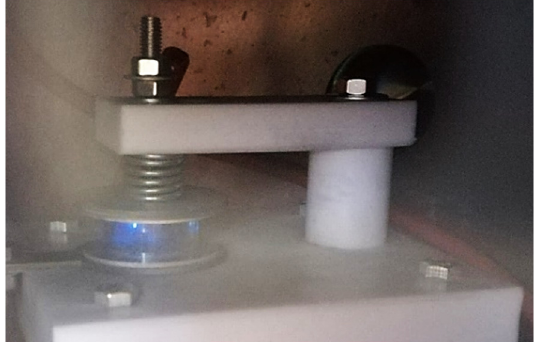
Figure 9. Undesired discharge between the electrodes. The picture was taken from the viewport of the vacuum chamber during a process using the old sample holder.